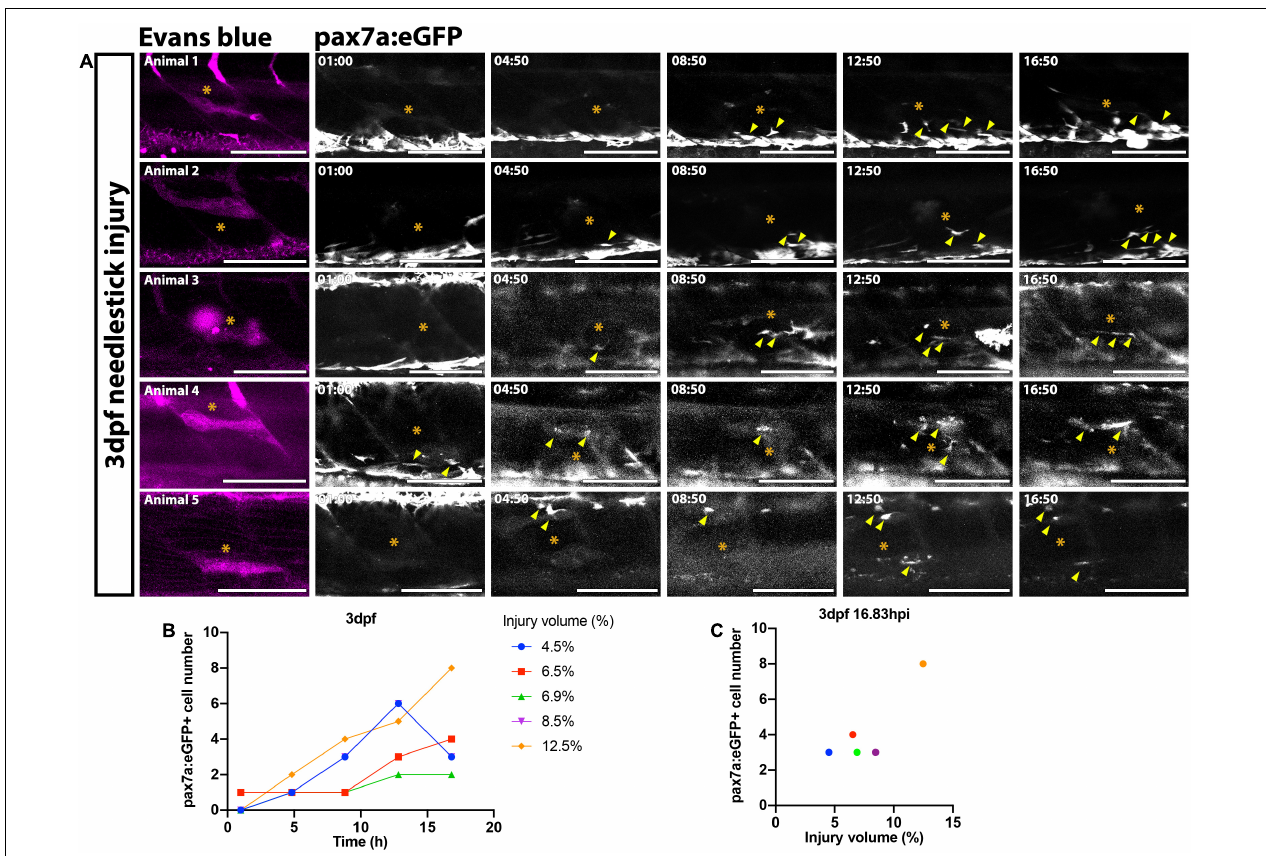
FIGURE 2 | Time-lapsed imaging reveals the extent of the muSC response is related to the injury size. Images from time-lapsed movies reveal pax7a:eGFP-expressing muSCs (arrowheads) respond to injury (asterisk) labeled with Evans Blue (magenta) in the myotome of five representative 3 dpf larvae ( A , animals 1–5). Images were acquired on a multiphoton microscope and maximum intensity projections generated. The number of pax7a:eGFP + cells in the myotome was quantified and plotted against time (B) and injury volume (C) . Each colored line (B) or dot (C) represents a single animal. Scale bars: 100 µ m (A)